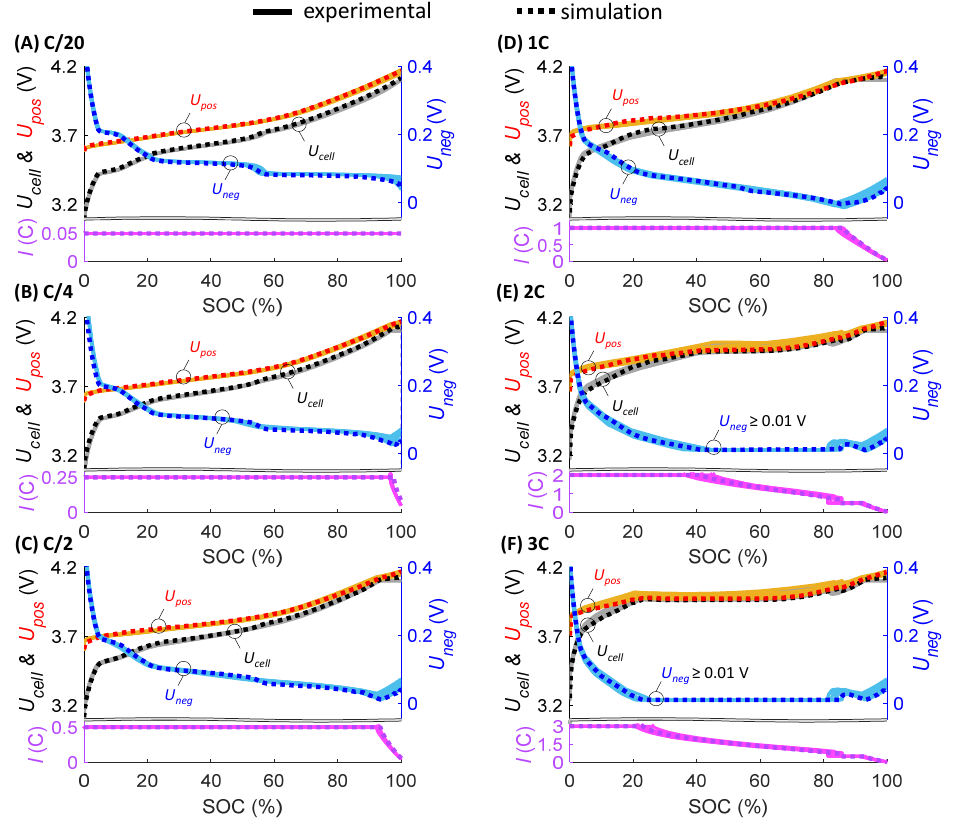
simulationexperimental